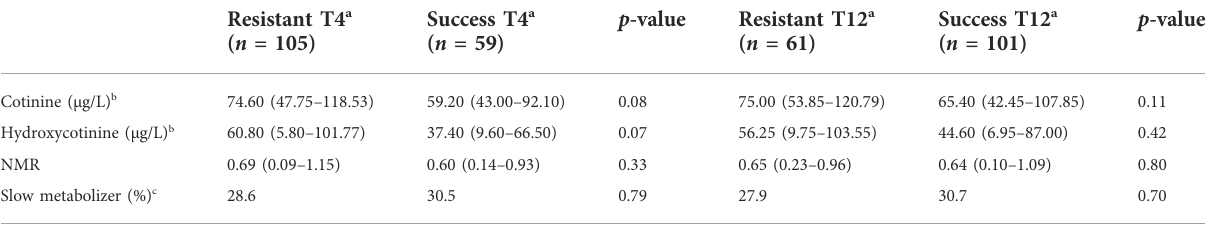
TABLE 2 Concentration of analytes according to outcome in patients treated with drugs for smoking